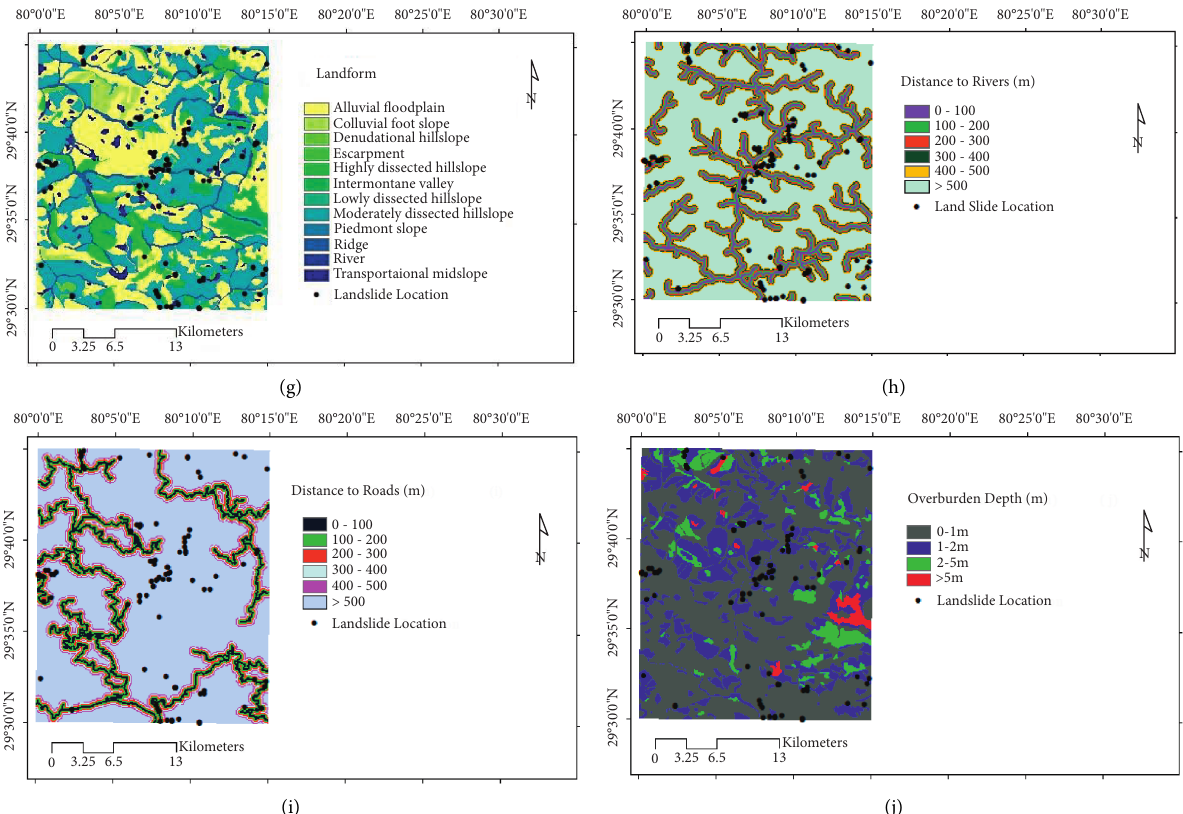
Figure 4: Landslide conditining factors maps used in landslide susceptibility analysis: (a) Slope. (b) Aspect. (c) Curvature. (d) Elevation. (e) Landcover. (f) SFM. (g) Landform. (h) Distance to rivers. (i) Distance to roads. (j) Overburden depth (data source: Geological Survey of India maps, Google Earth Maps, and Aster